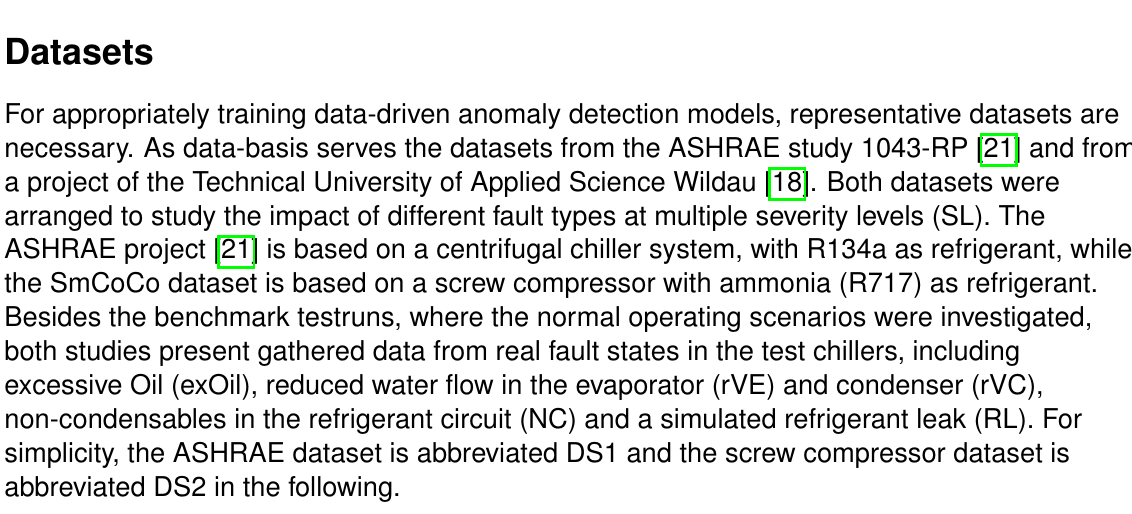
Table 2. Optimized parameter for every OCSVM-based approach with reached performance DS1 DS2 method γ DS 1 ν DS 1 F 1 DS 1 γ DS 2 ν DS 2 F 1 DS 2 PCA-T²-SPE — — 89 , 43% — — 69 , 10% PCA-PC-OCSVM 1 , 1 0 , 04 70 , 33% 1 , 9 0 , 03 70 , 14% PCA-R-OCSVM 0 , 7 0 , 06 95 , 92 % 3 , 3 0 , 01 82 , 58% EKF-ROSVM 7 , 0 0 , 01 89 , 14% 3 , 4 0 , 02 88 , 50 %